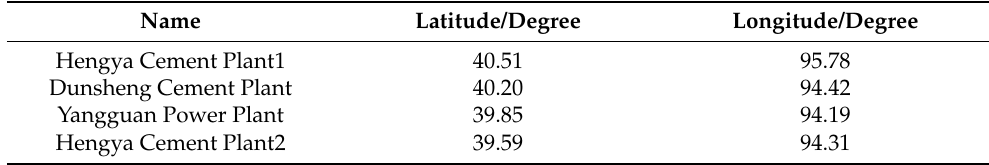
Table 4. CO 2 emission source information on flight